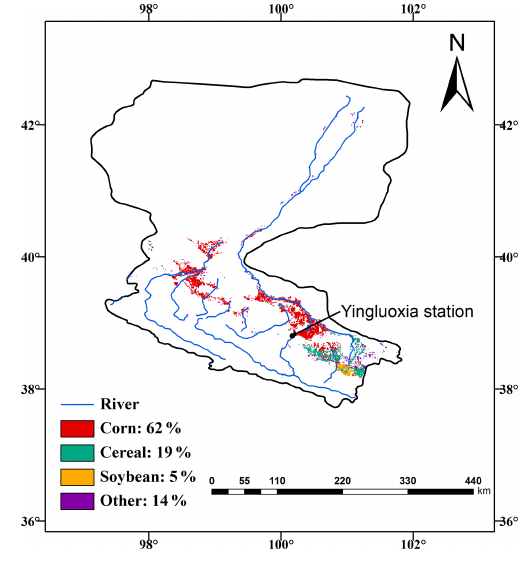
Figure 1. Study area and location of the Heihe River basin in north- western China, the spatial pattern of crops in the basin, and the lo- cation of the Yingluoxia hydrologic